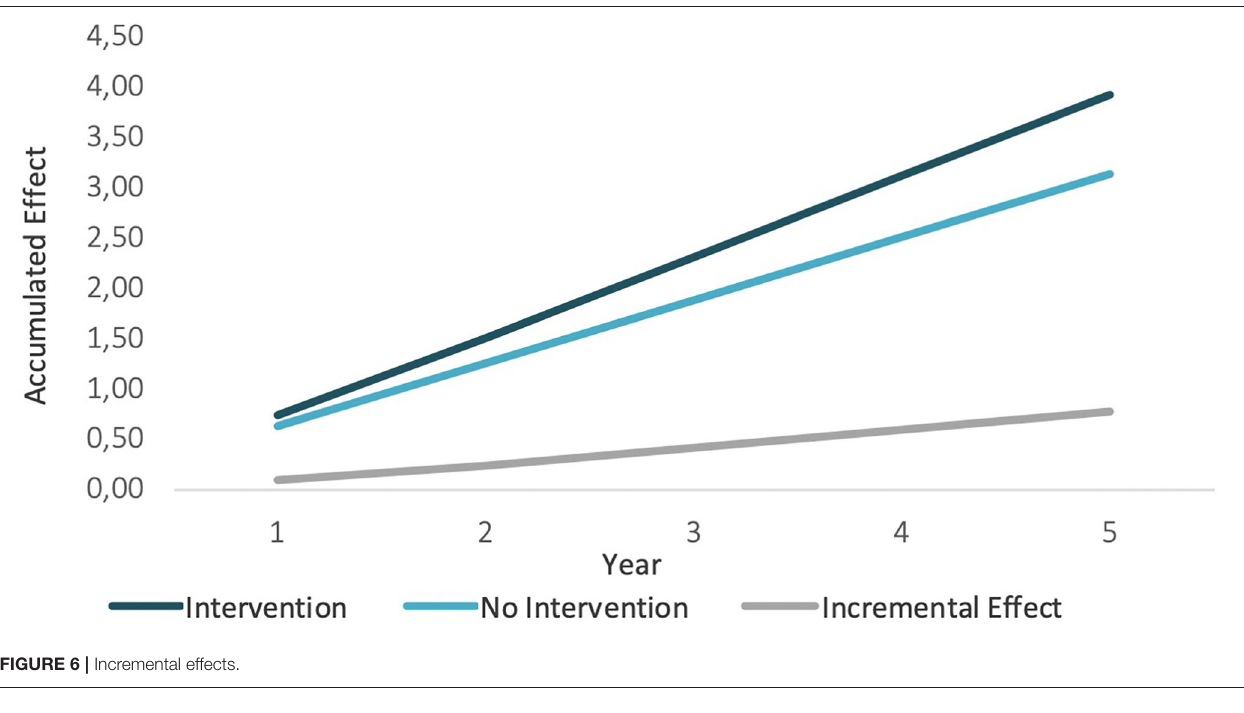
FIGURE 6 | Incremental effects.